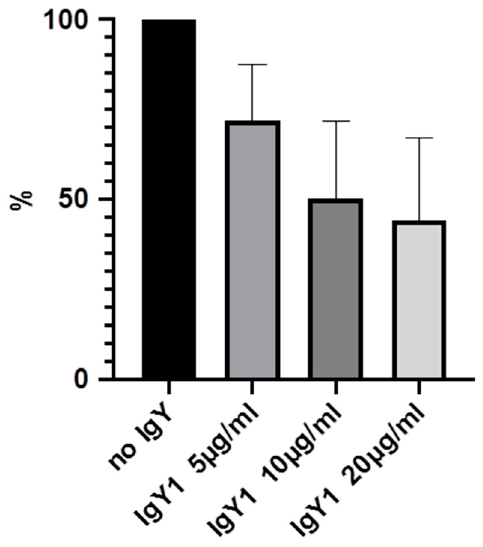
Molecules 2020 , 25 , x FOR PEER REVIEW Figure 3. Inhibition of biofilm formation in % after 24 h incubation with 5, 10 and 20 µg/mL IgY1.